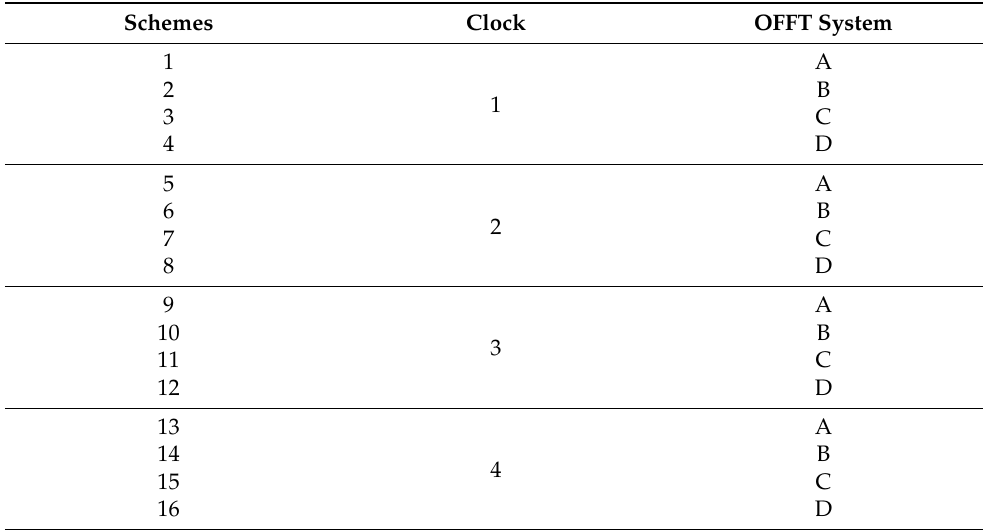
Table 4. Scheme elements of using different clocks and OFFT systems.